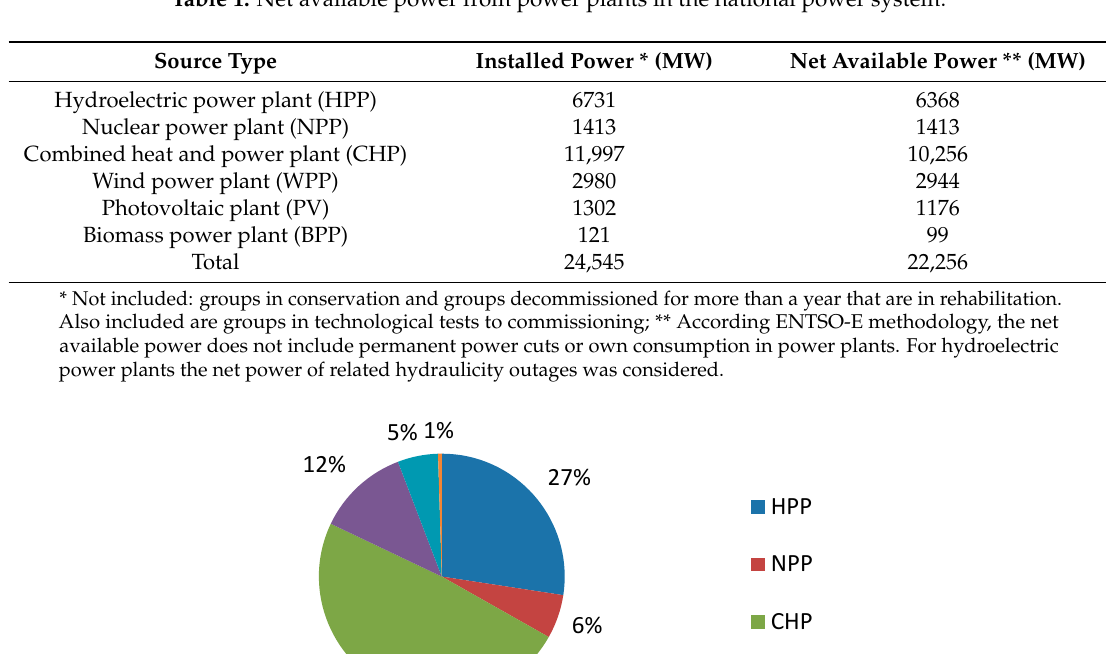
Table 1. Net available power from power plants in the national power system.